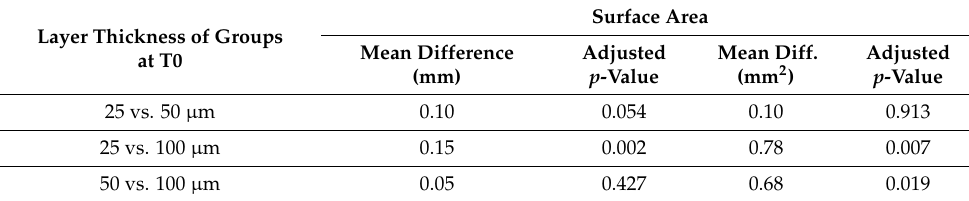
Table 2. The intergroup comparisons of the linear dimensions and surface area, with the 25 µ m, 50 µ m, and 100 µ m groups at printing time zero (T0), using one-way ANOVA and Tukey’s post hoc. Layer Thickness of Groups at T0